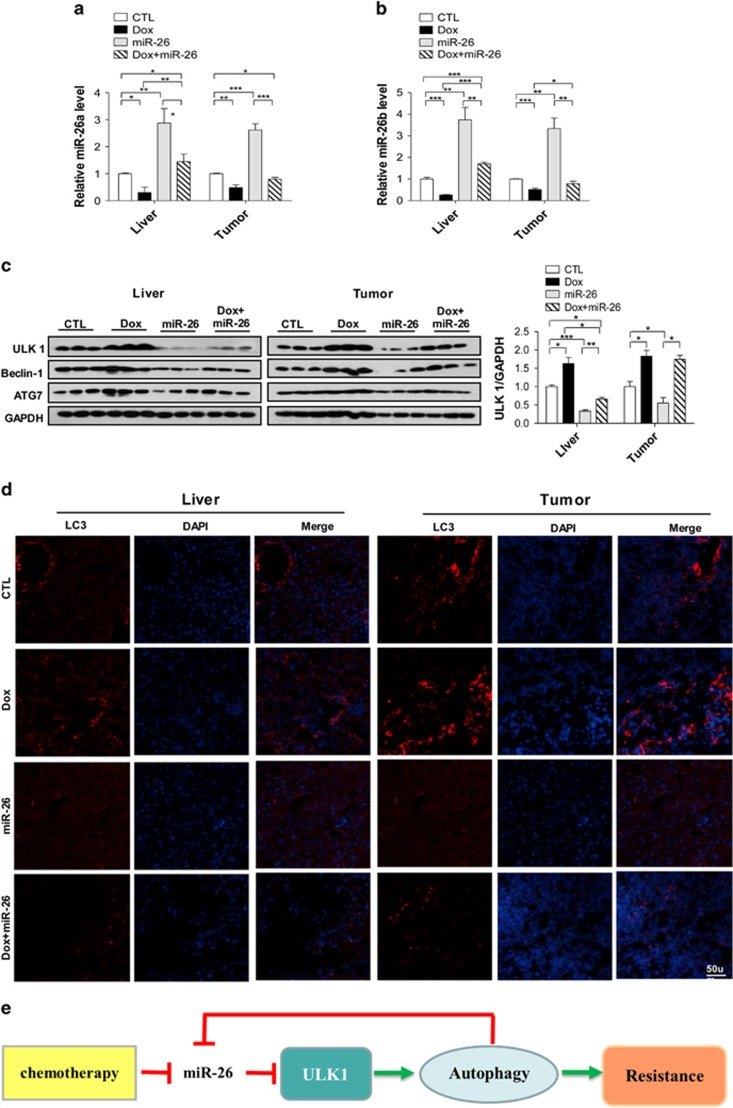
Intravenous injections of miR-26a/b-expressing lentivirus enhance the efficiency of chemotherapeutic drugs by inhibiting autophagy in vivo. (a and b) Quantitative analysis of miR-26a/b levels in tumors and livers of four mouse groups. (c) Western blotting analyses of ULK1, Beclin-1 and ATG7 proteins in the tumors and livers of mice that were treated with PBS, Lenti-miR-26, Dox or Dox plus Lenti-miR-26. (d) Representative micrographs of the immunofluorescence staining of LC3 puncta in tumor and liver tissues. Red indicates LC3; blue indicates nuclei. (e) Schematic illustrating how miR-26 induces chemosensitivity to drugs. MiR-26 inhibits autophagy and sensitize tumor cells to chemotherapy by suppressing ULK1 and downstream events. Pointed arrows and blunted arrows indicate activation and repression, respectively. *P<0.05; **P<0.01; and ***P<0.001